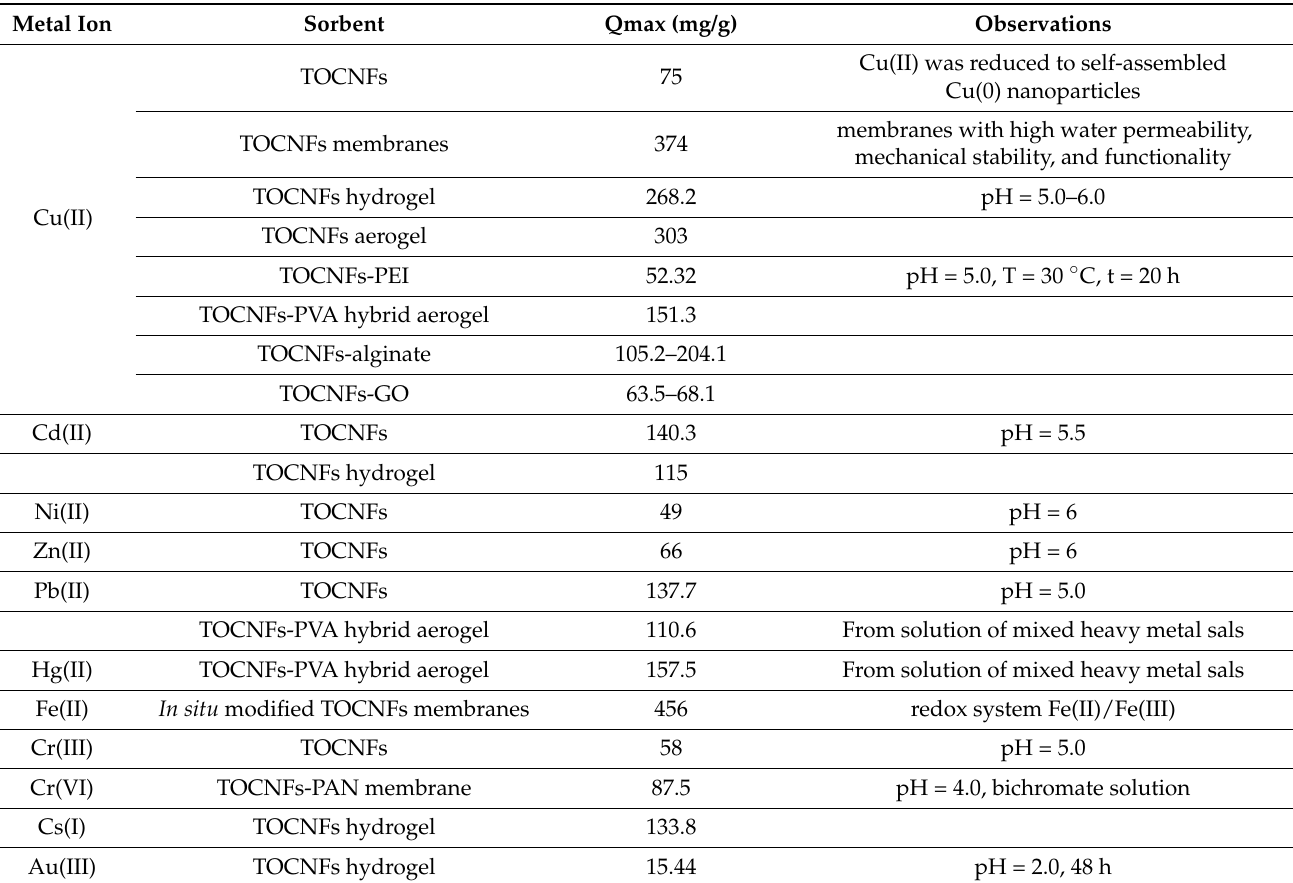
Table 1. Retention of some heavy metal ions onto oxidized cellulose-based sorbent materials (modi- fied from reference